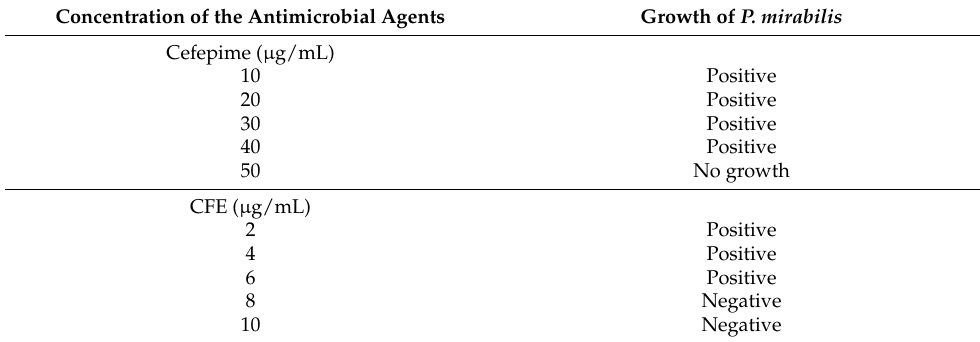
Table 2. Minimum inhibitory concentrations (MICs) of the antibiotic cefepime and clove flower extract (CFE).